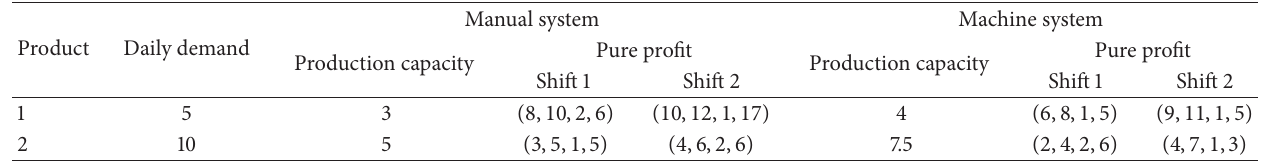
Table 1: The relationship among product demand, production capacity, and pure profit.